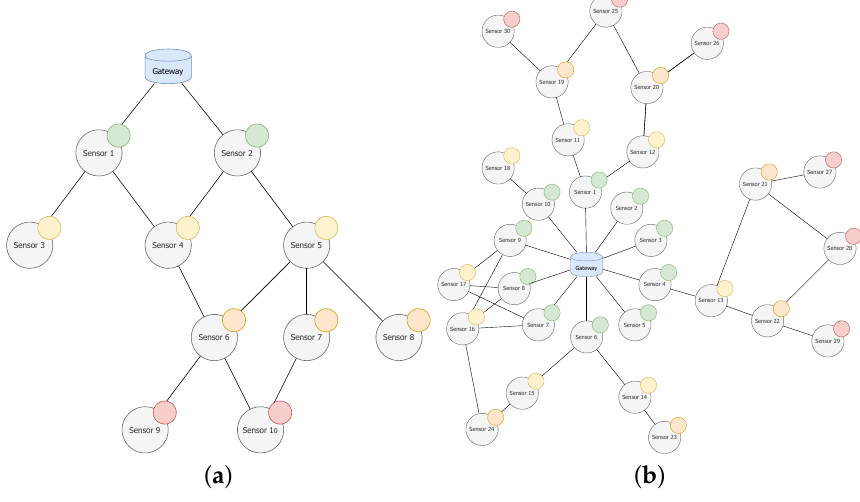
Figure 8. Topology for ( a ) testbed 1 and ( b ) testbed